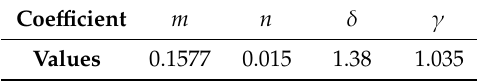
Table 8. Optimal correction function coefficient.